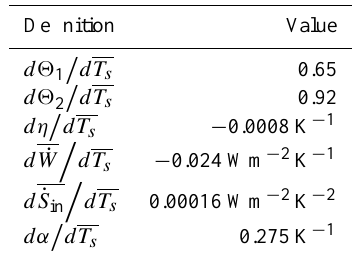
Table 2. Parameterisations a